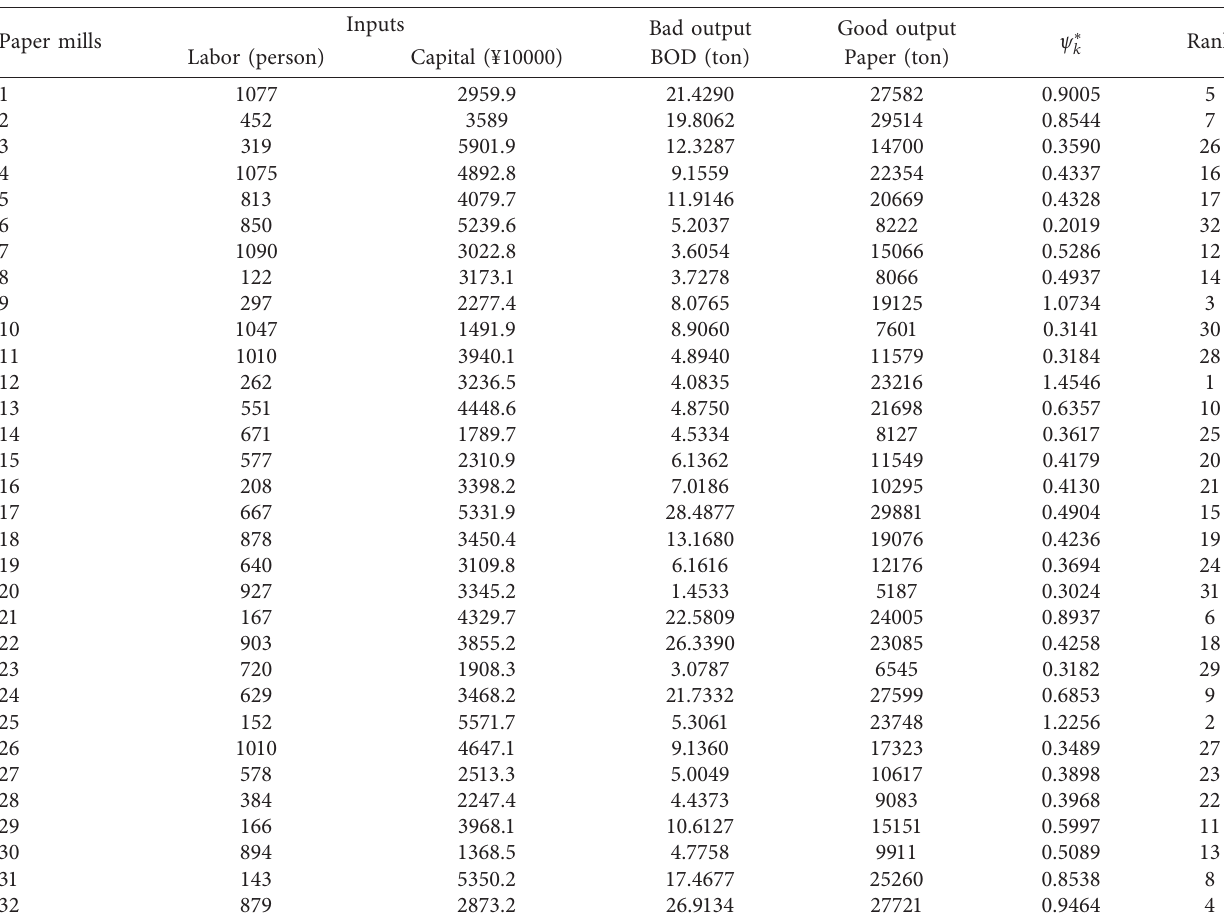
Table 5: The Data set and efficiency results of 32 paper